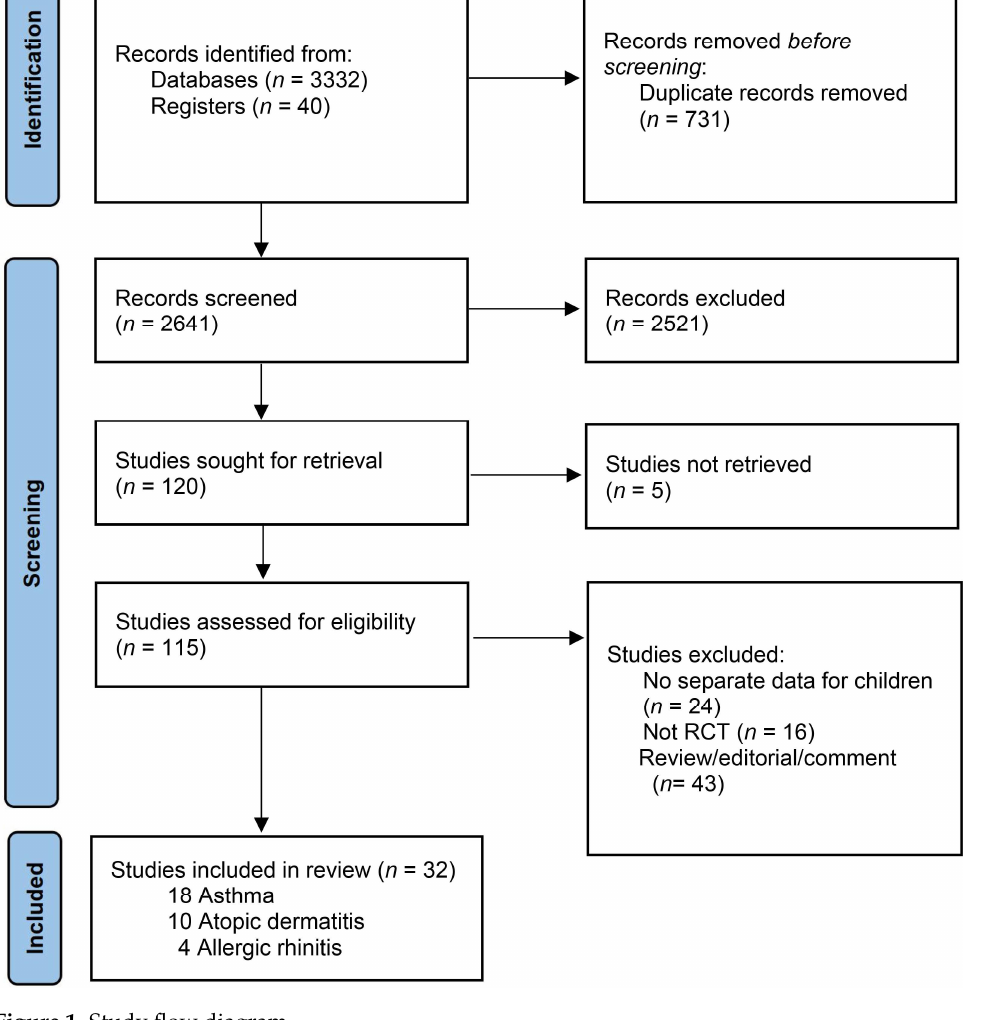
Figure 1. Study flow diagram